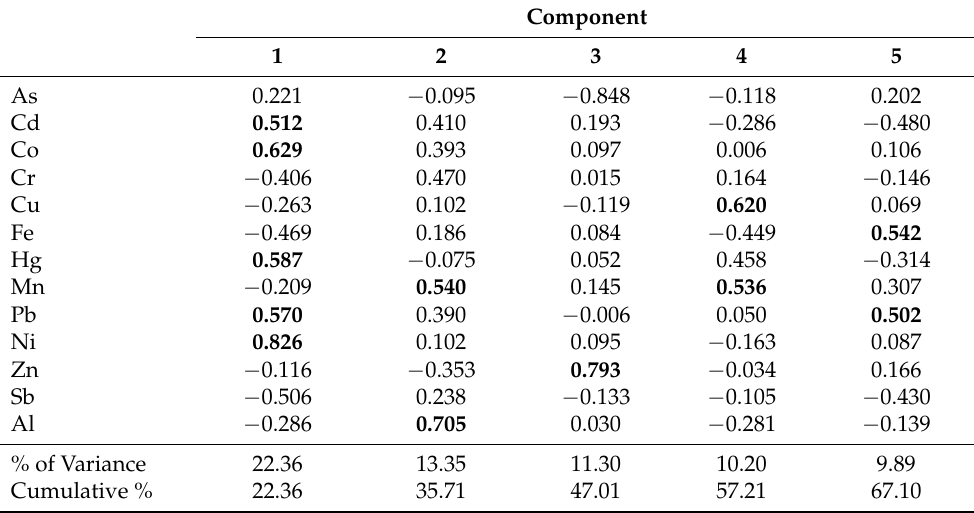
Table 5. Principal component loadings and variance percentage for the five